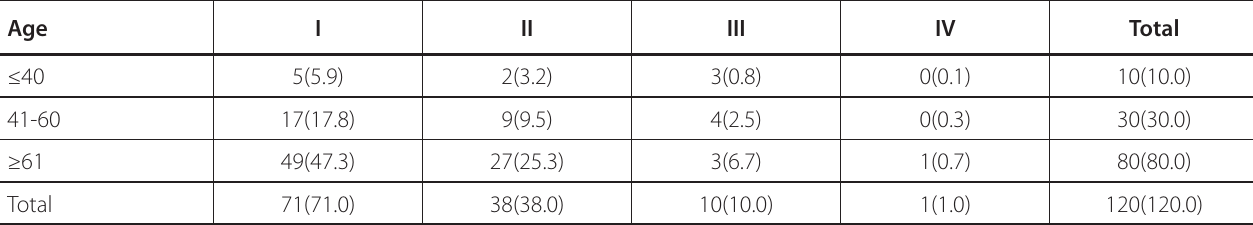
Table 5 . Comparison of types between age groups.